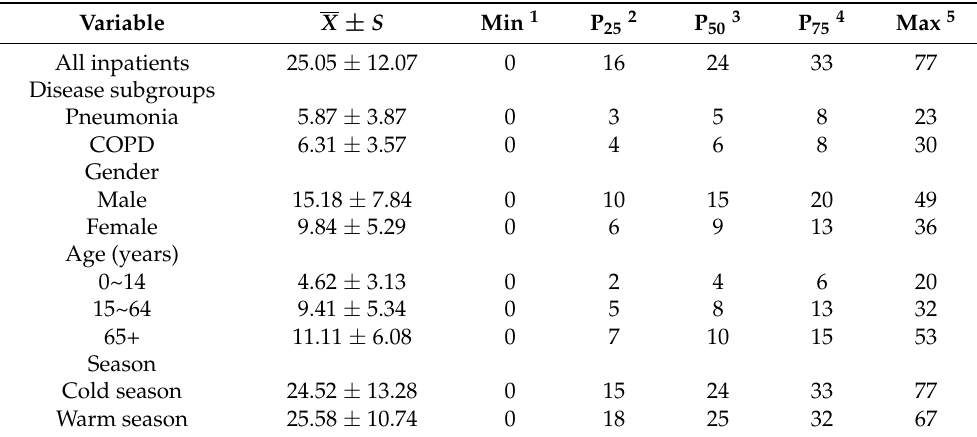
Table 4. Basic information for the period of 2015–2019 on the number of daily hospital admissions for respiratory diseases.